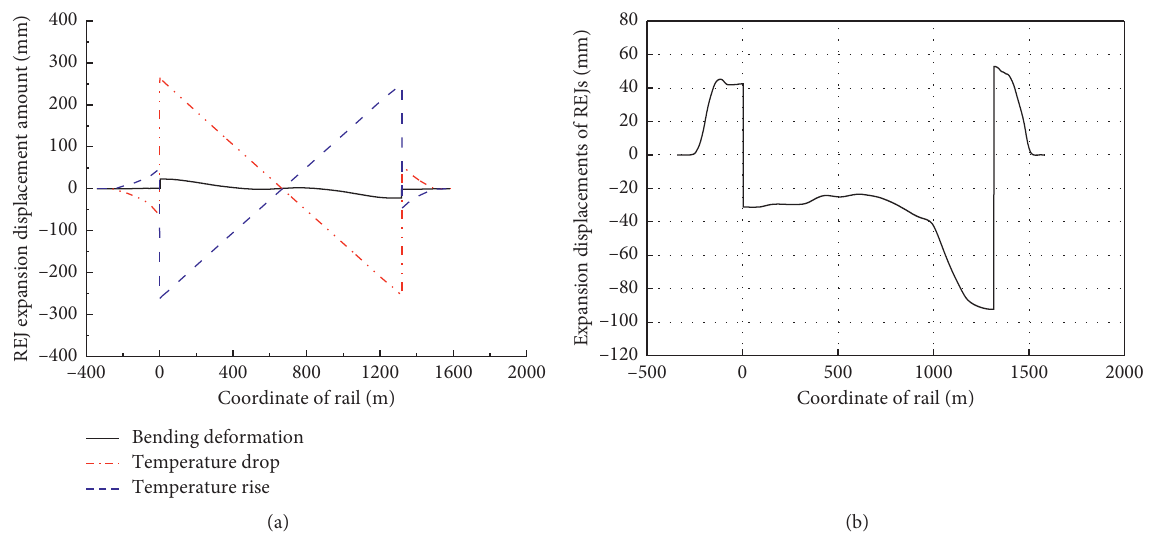
Figure 13: REJ expansion displacements. (a) Effect of temperature and bending conditions. (b) Effect of the seismic load.